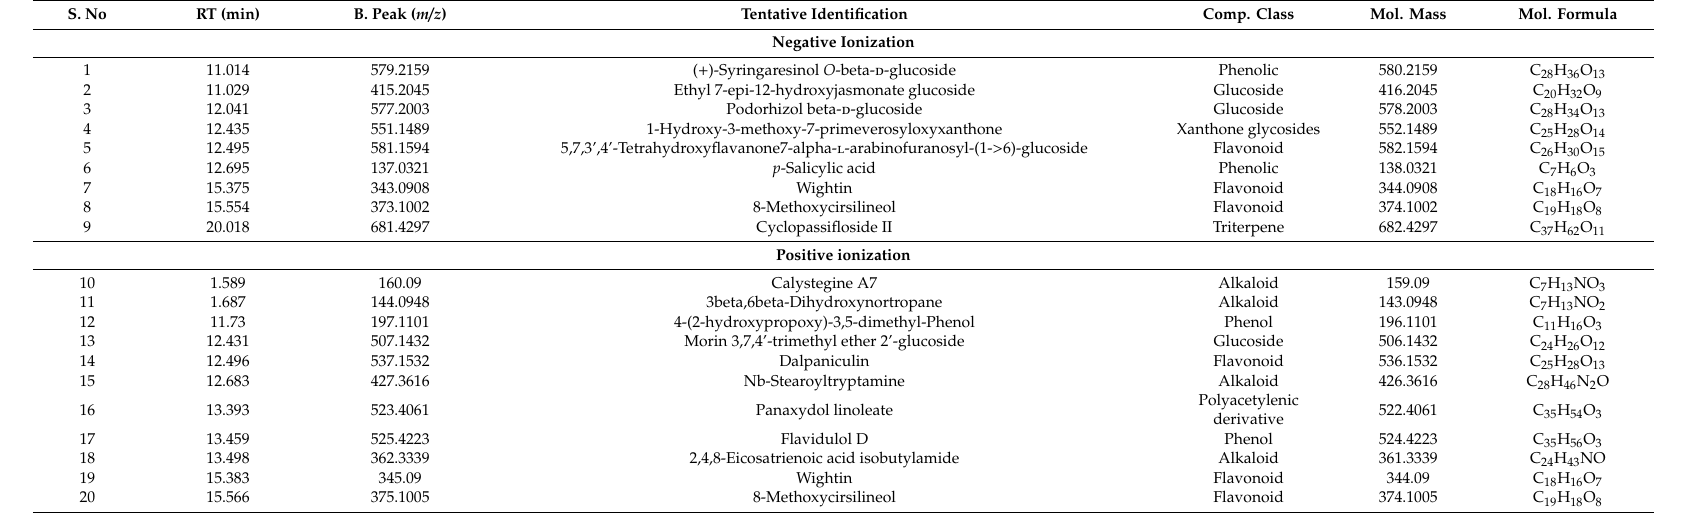
Table 2. Ultra-high performance liquid chromatography-mass spectrometry (UHPLC-MS) secondary metabolites composition of B. papillosa aerial dichloromethane (DCM) extract (negative and positive ionization